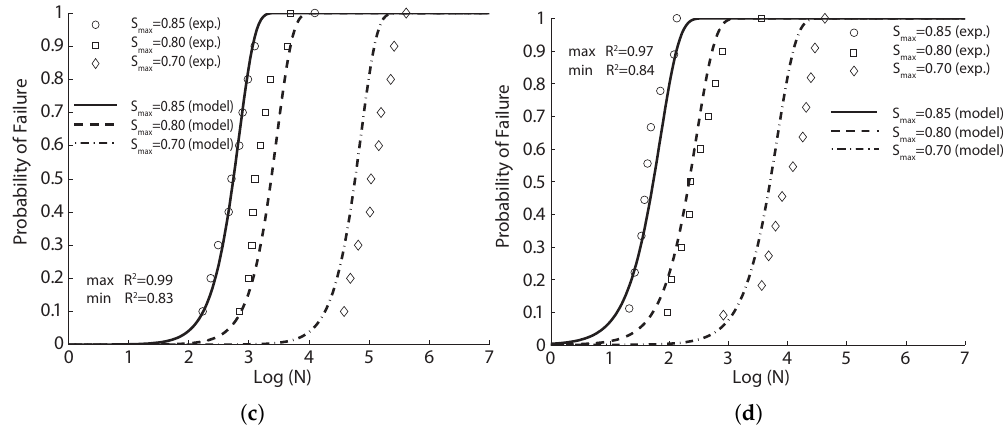
Figure 7. Comparison of the flexural fatigue data of Mohammadi and Kaushik [17] with the fitted probabilistic model Equation (8) for concrete reinforced with fibers of 50 mm in length and volume ratios of ( a ) 0%; ( b ) 1%; ( c ) 1.5% and ( d ) 2%.